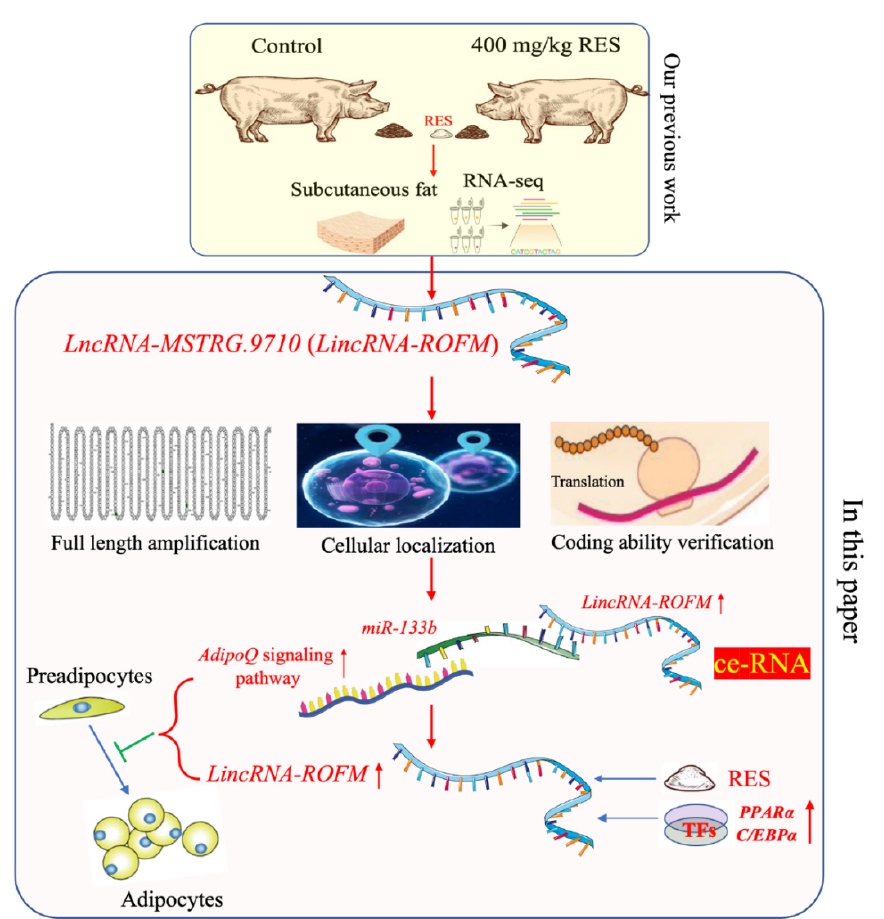
Figure 9. Study routes and block diagram. The LincRNA-ROFM were found in pig subcutaneous fat between control group and 400 mg/kg RES group by RNA-seq on the basis of previous work in our group. In this paper, we verified the functional mechanism of RES to reduce the thickness of porcine subcutaneous fat by LincRNA-ROFM through molecular and cell biological experiments.